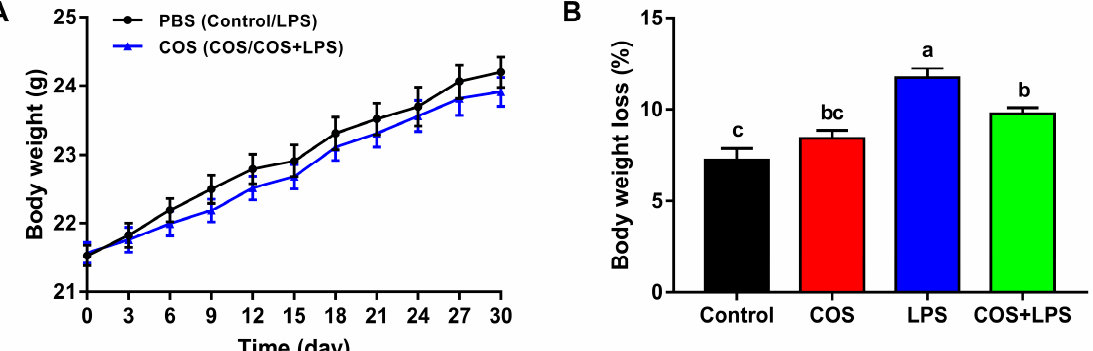
Figure 1. Effects of COS on body weight in mice. ( A ) Changes of body weight. ( B ) Body weight loss. The data are presented as the mean ± SE ( n = 12). Values without a common letter are significantly different ( p < 0.05). PBS, phosphate-buffered saline; COS, chitosan oligosaccharide; and LPS, Lipopolysaccharide.